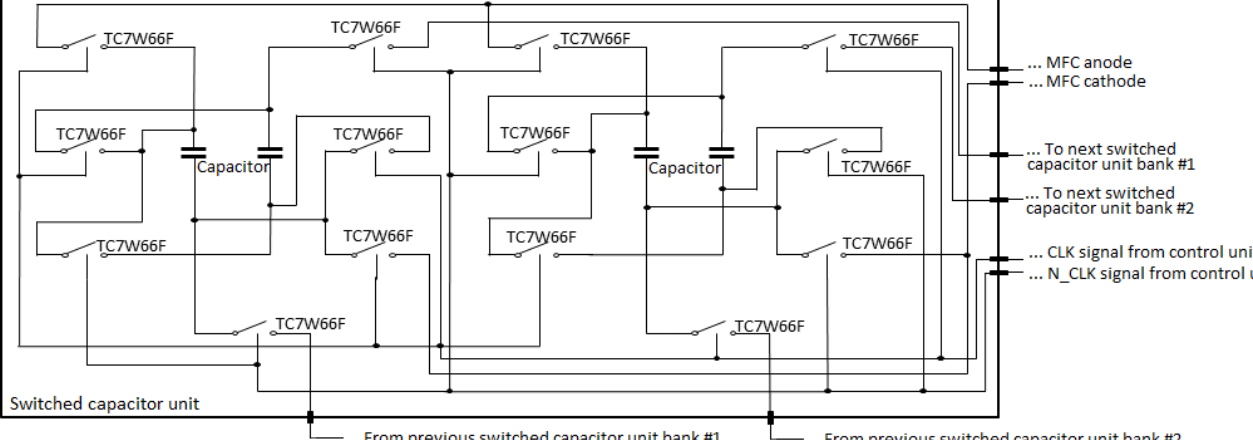
Figure 2. Switched capacitor